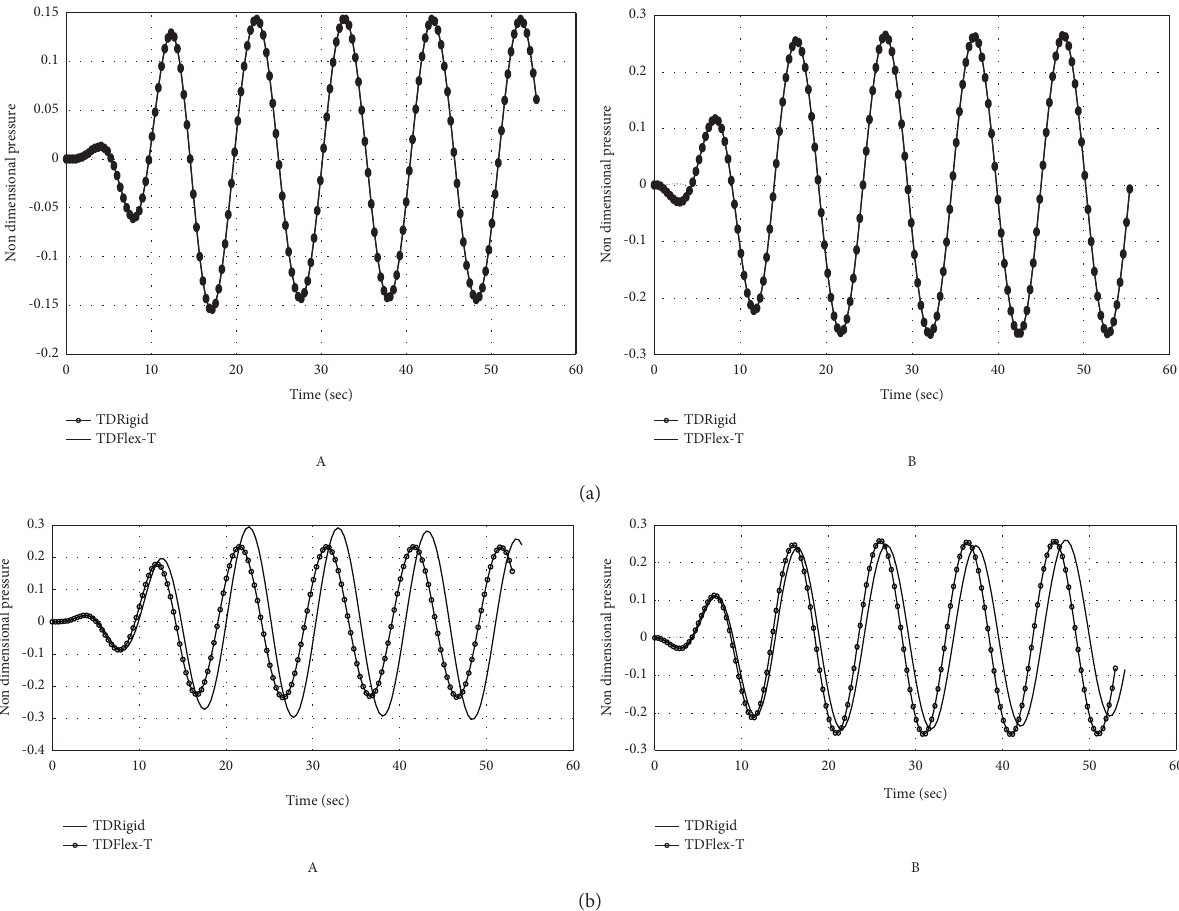
Figure 19: (a) Pressure time history of S175 hull at midship region, F 2). (B) Pressure at bottom surface (Figure 17; location point 5). (b) Pressure time history of ULC at midship region, F Pressure at free surface (Figure 17; location point 2). (B) Pressure at bottom surface (Figure 17; location point